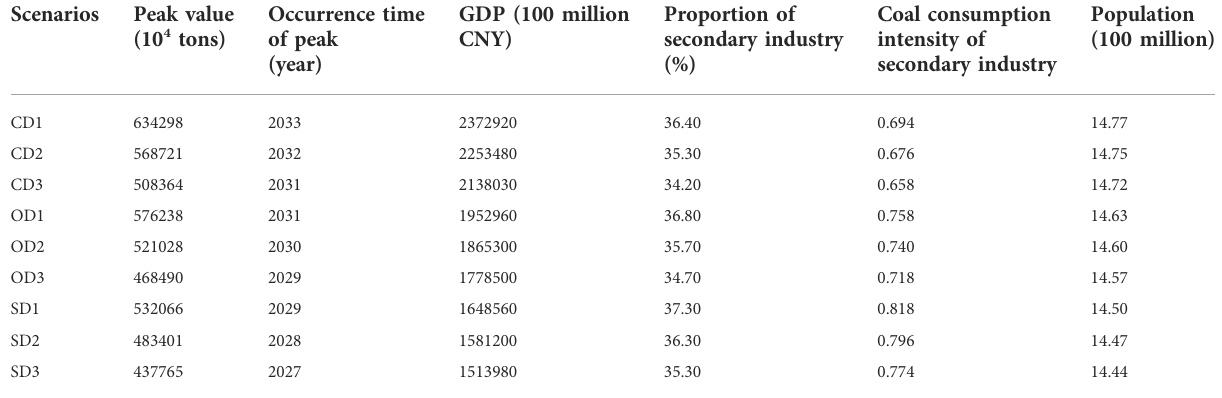
TABLE 13 China ’ s coal consumption peak and its related indicators.